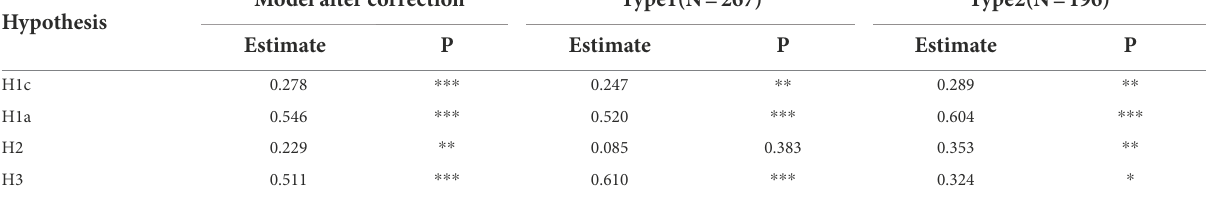
TABLE 8 Modified model hypothesis